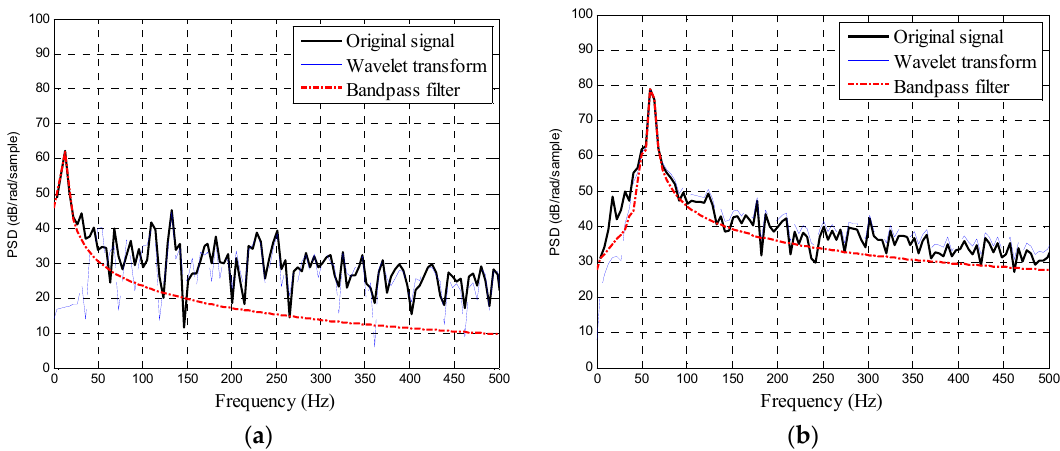
Figure 7. Frequency spectrum chart of the radar signal analysis at a tilt angle of 30°: ( a ) speed = 0.2 m/s; and ( b ) speed = 1.0 m/s.